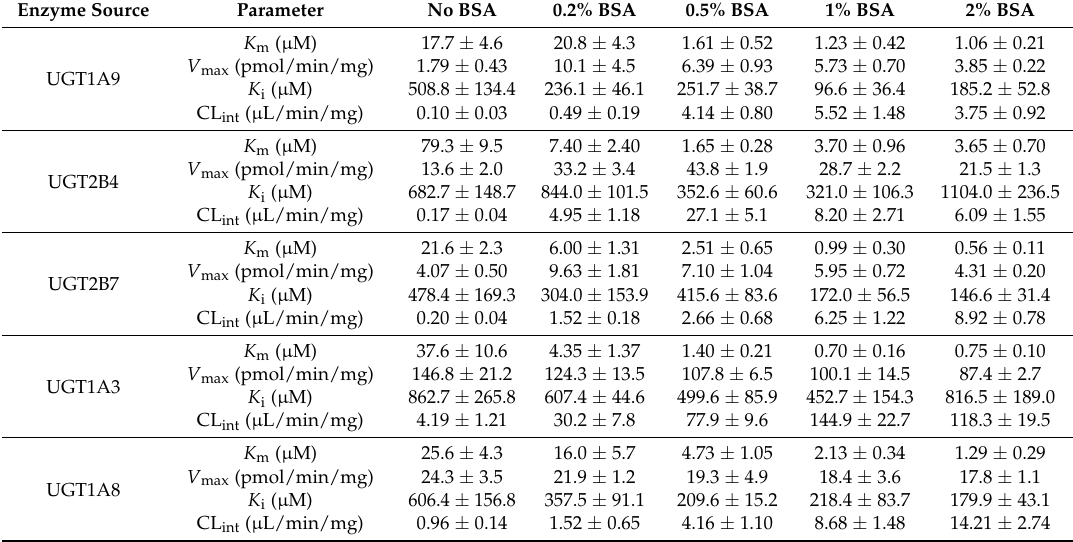
Table 3. Kinetic parameters of Ib glucuronidation in UGT1A9, 2B4, 2B7 and UGT1A3, 1A8 in the absence and presence of BSA. ( n = 3, mean ±